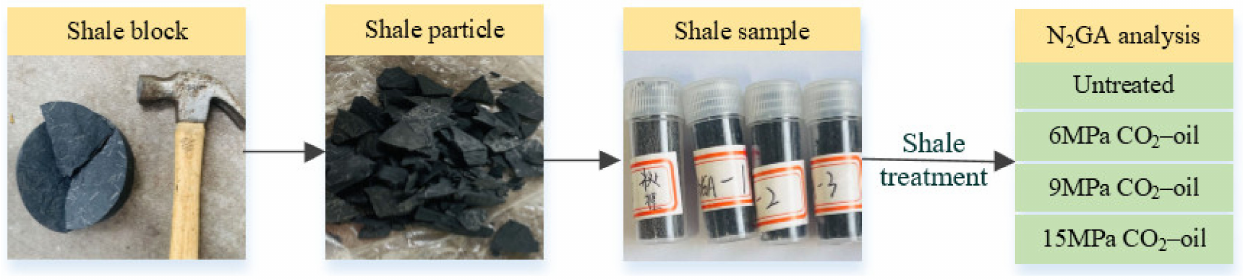
Figure 2. Experimental characterization method and treatment scheme.